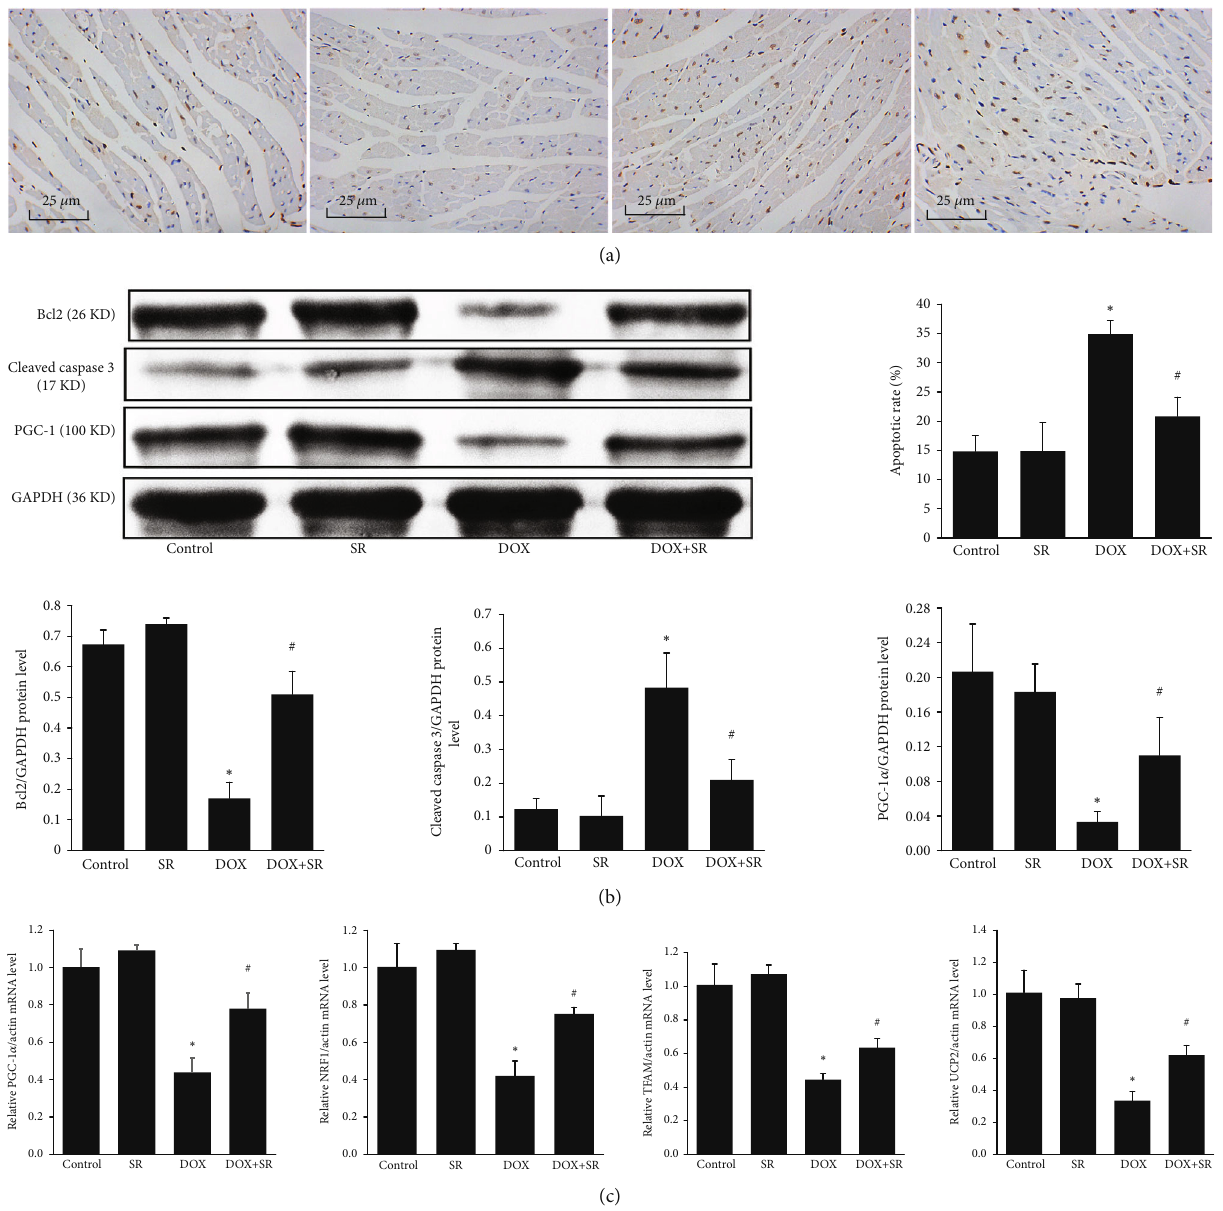
Figure 5: E ff ects of SR9009 on cell apoptosis and PGC-1 α signaling pathway in doxorubicin-treated mouse heart. (a) Representative image of TUNEL staining. The apoptotic rate was expressed as the ratio between the number of TUNEL-positive cells (brown) and the total number of cardiomyocytes × 100 % . Scale bar: 25 μ m. (b) Representative western blot result of Bcl2, cleaved caspase 3, PGC-1 α , and GAPDH was used as an internal control. (c) mRNA levels of PGC-1 α , NRF1, TFAM, and UCP2 measured by RT-PCR. The results are expressed as mean ± SD , n = 5 . ∗ Compared with the control group, P < 0 : 05 . # Compared with the DOX group, P < 0 : 05